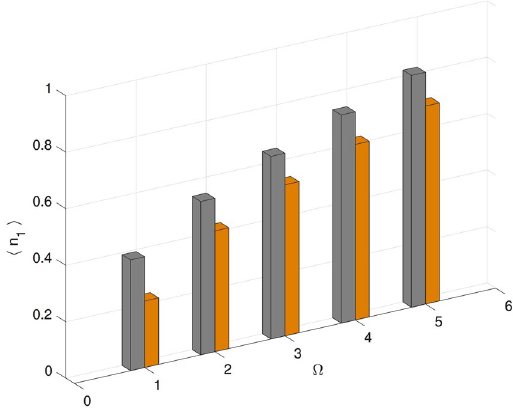
Figure 2. Boson number expectation value on site 1 as function of varying drive strength (Ω) for a uniform trimer. Gray bars correspond to the lower sign choice in the parameters listed in Table 1(a), Case 2; and orange bars correspond to the upper sign choice. The transformation from the lower sign choice to the upper sign choice is not number-conserving and the boson number expectation value is not